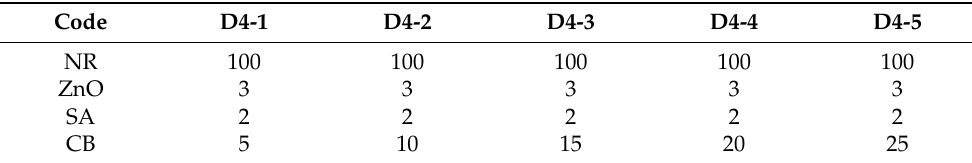
Figure 4. The process flow diagram of the internal mixing technology.